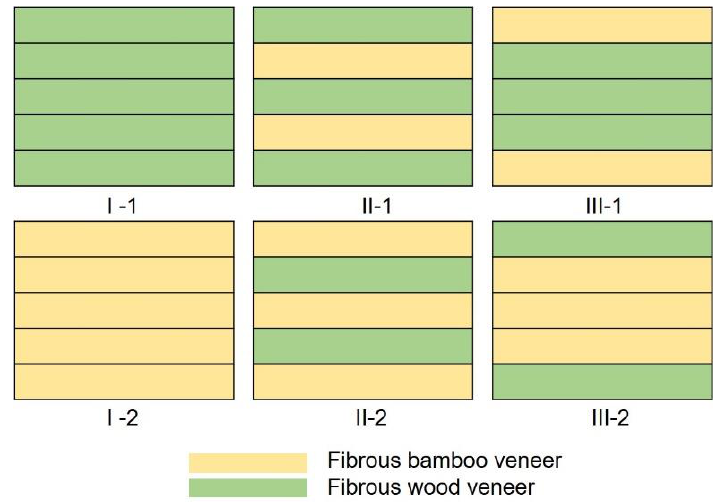
Figure 1. Layup designs of wood/bamboo LC panels.